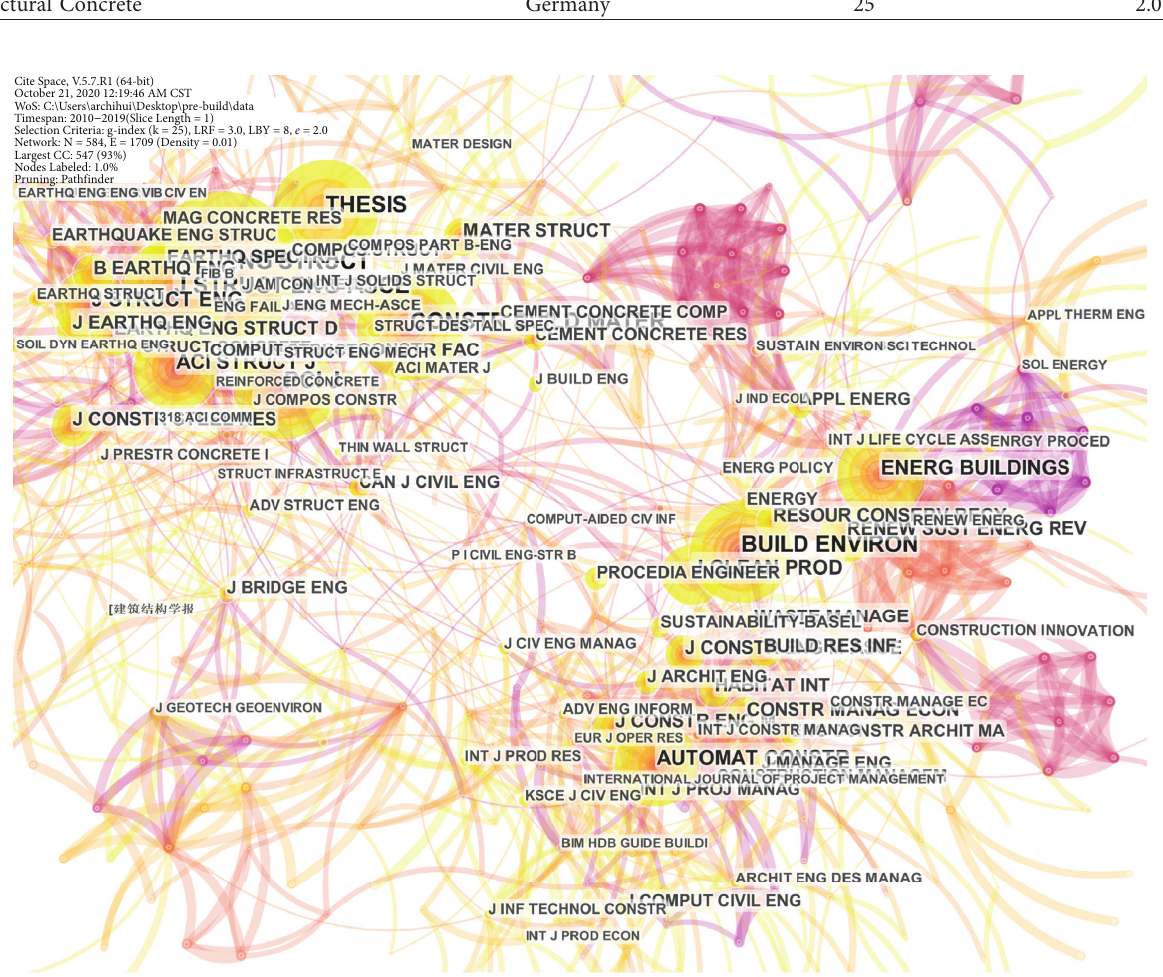
Figure 6: Network of journal